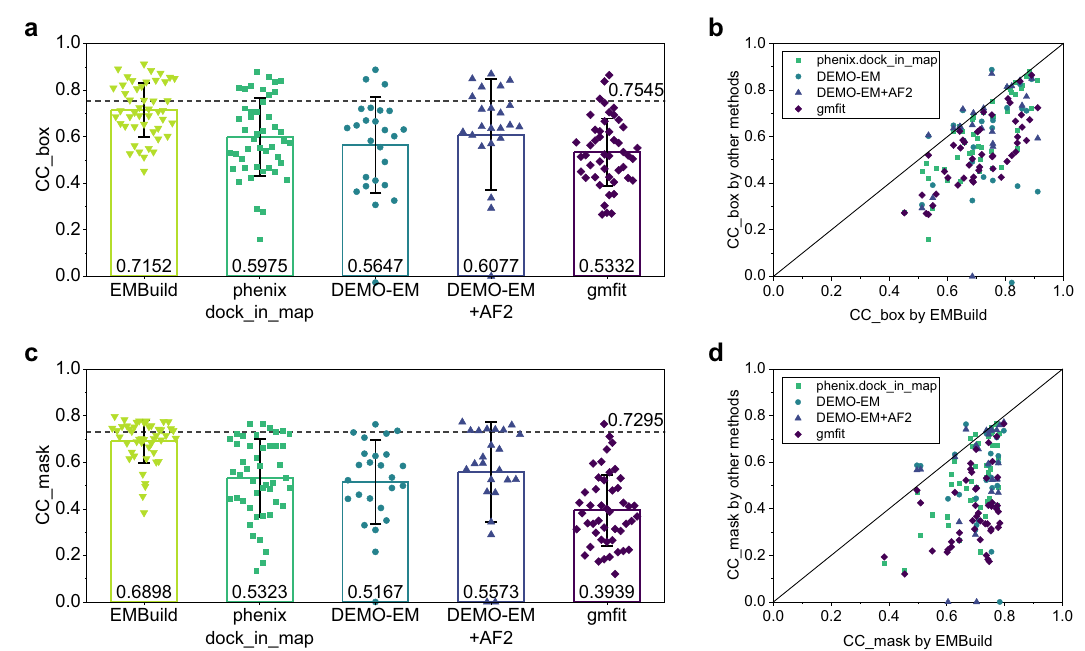
Fig. 5 Evaluating map-model correlation coef fi cient (CC) of built models by EMBuild, phenix.dock_in_map, DEMO-EM, DEMO-EM with AlphaFold2 structures, and gm fi t, on the test set of 47 single-particle EM maps. a , c Average CC_box ( a ) and CC_mask ( c ) values among n = 47 individual test cases. Error bars indicate ±1.0 standard deviations. The dashed lines indicate the corresponding average CC values ( n = 47 test cases) achieved by the PDB structures. b , d Comparison of the CC_box ( b ) and CC_mask ( d ) values on each test case between EMBuild and other methods, respectively. Source data are provided in the Source Data fi